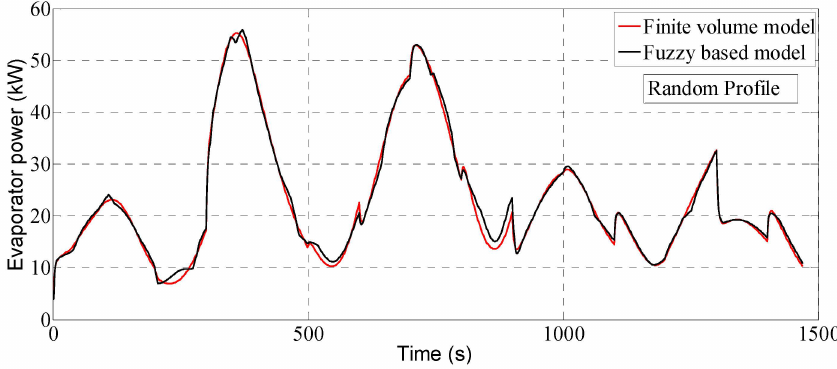
Figure 25. Prediction of evaporator power with respect to random profile.